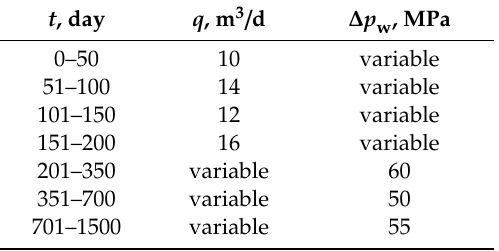
Table 9. Production history of Case 4 for a vertical well producing at multiple rate / pressure